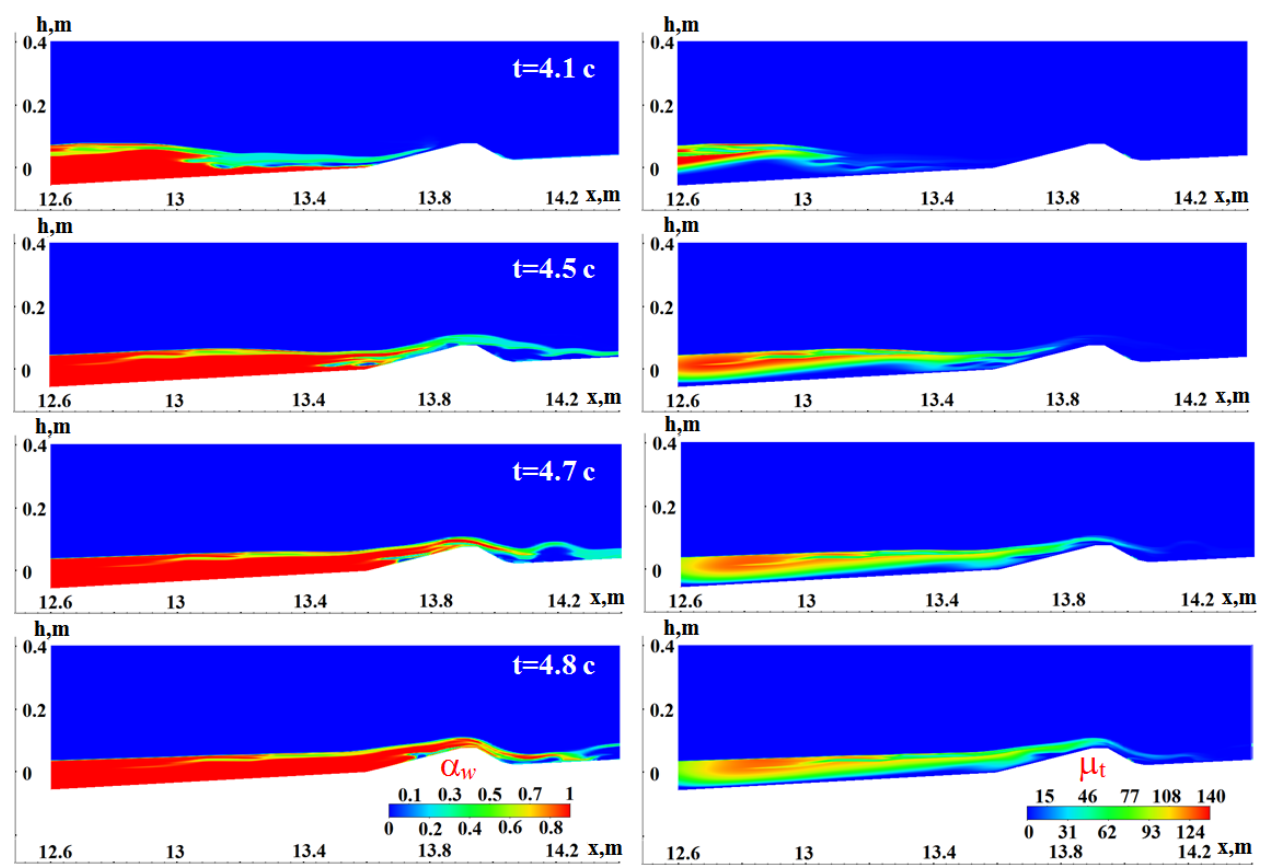
Figure 12. Time series of the free-surface position and turbulence viscosity for setup 4.